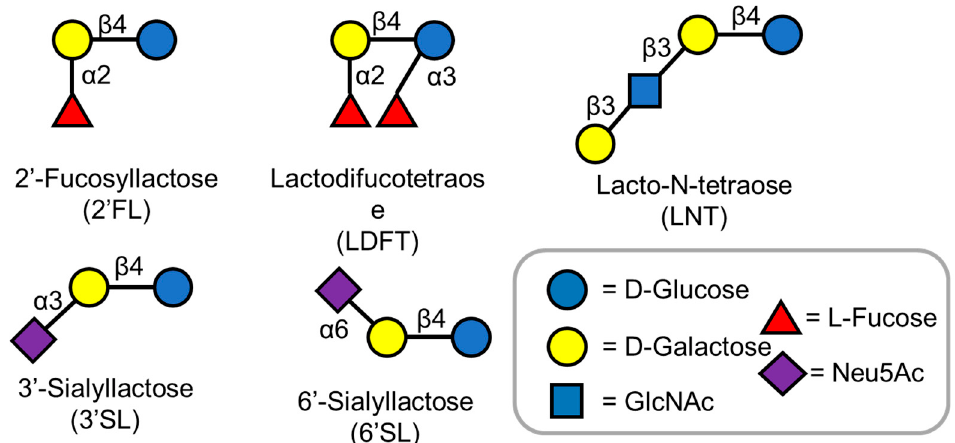
Figure 1. Structures of Human milk oligosaccharides described in this review. HMOs are made of five basic monosaccharides: D-glucose, D-galactose, L-fucose, N-acetyl-D-glucosamine (GlcNAc), and N-acetylneuraminic acid (Neu5A).